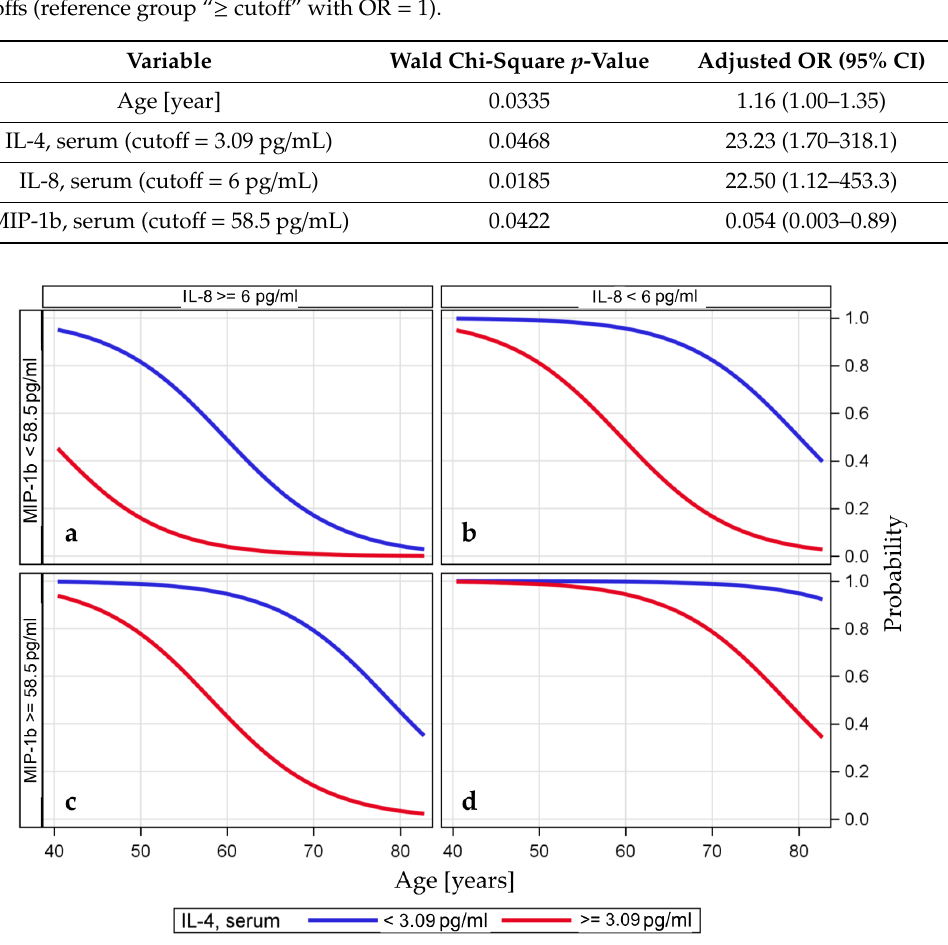
Figure 4. Predicted probability of a TA-specific response based on a multiple logistic model including the variables IL-4, IL-8, and MIP-1b (dichotomized at the optimal cutoff value) and age (continuous variable). The predicted probability of being a responder is visualized based on the three serum cytokines dichotomized at their optimal cutoff values and the variable age. The probabilities of having IL-4 levels above the optimal cutoff value are shown as blue lines, and the probabilities of having IL- 4 levels below the cutoff value are shown as red lines. The categorization according to the optimal